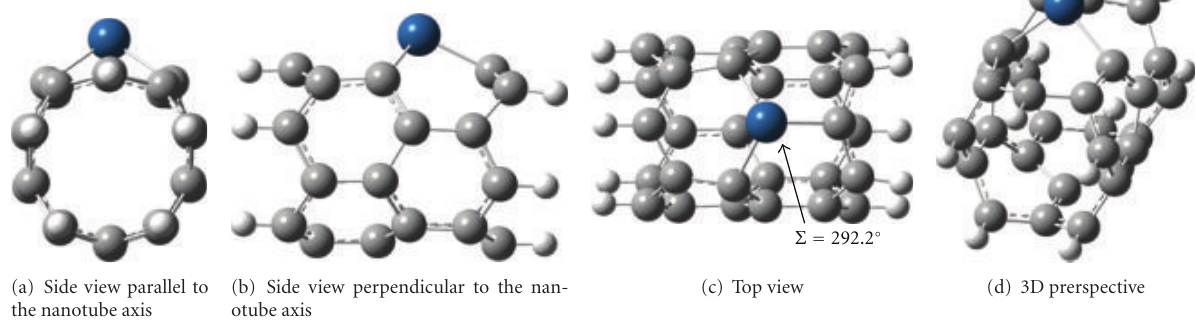
Figure 27: Optimized geometry of model (5,0) Pt-doped SWCNT segment [45]. Legend: dark grey = carbon, light grey = hydrogen, blue = platinum.